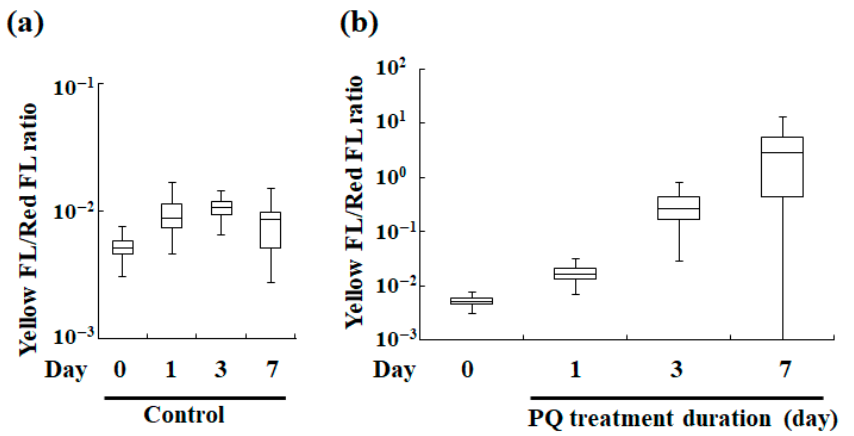
Figure 4. Box-and-whisker diagram analysis of ratios of the yellow fluorescence intensity (Yellow FL) to the corresponding red fluorescence intensity (Red FL) of P. bursaria . ( a ) Changes in the Yellow FL/Red FL ratio throughout the cell cycle of control P. bursaria host cell. ( b ) Changes in the Yellow FL/Red FL ratio in cells treated with PQ (0.1 µg/mL). The upper and lower error bars indicate the maximum and minimum value, respectively. A bar in each box represents the corresponding median value ( n > 320 signals [320 intact P. bursaria